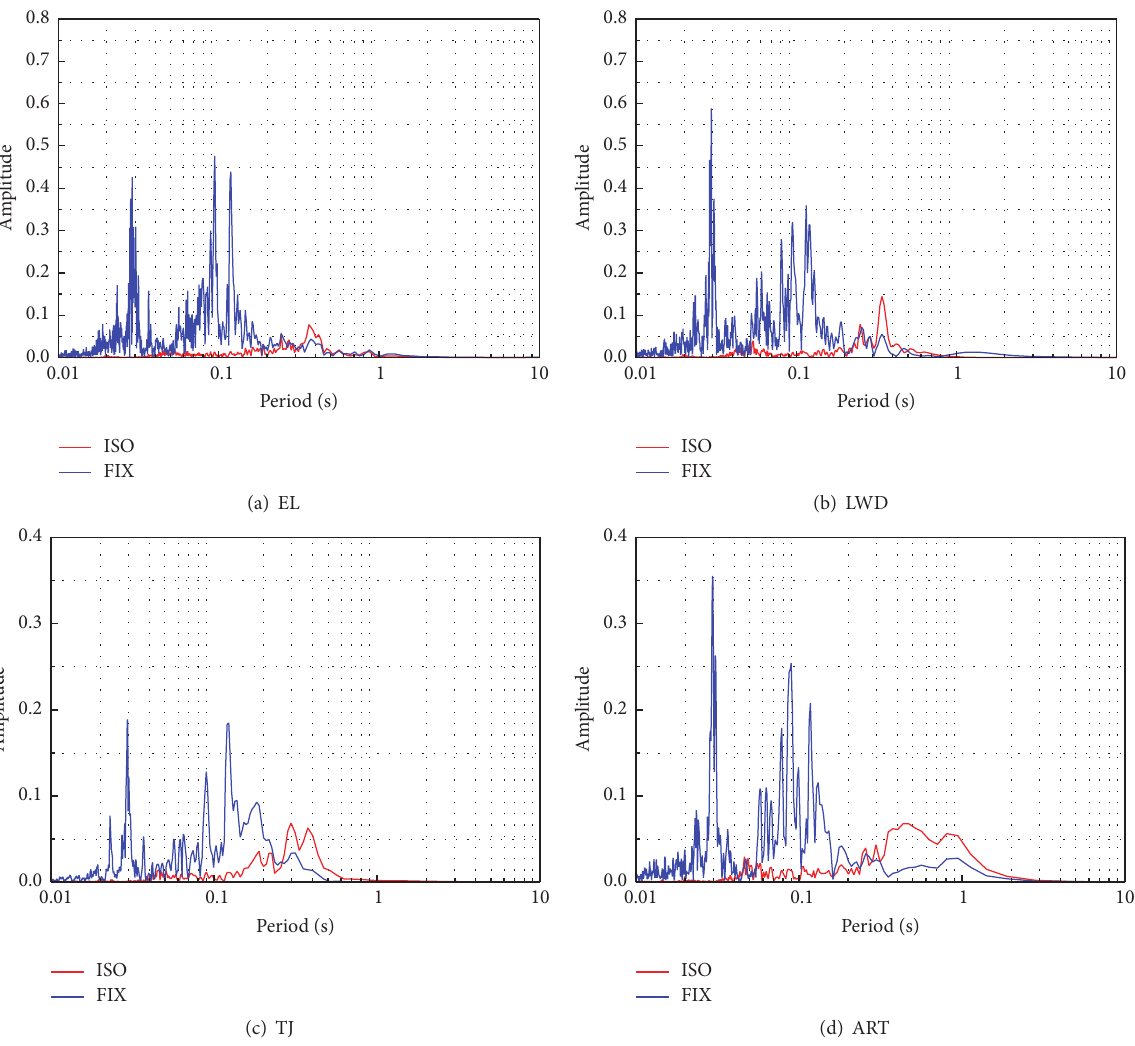
Figure 17: Comparisons on Fourier amplitude spectra of roof acceleration time history of the isolated and fixed structure under major earthquake in direction x